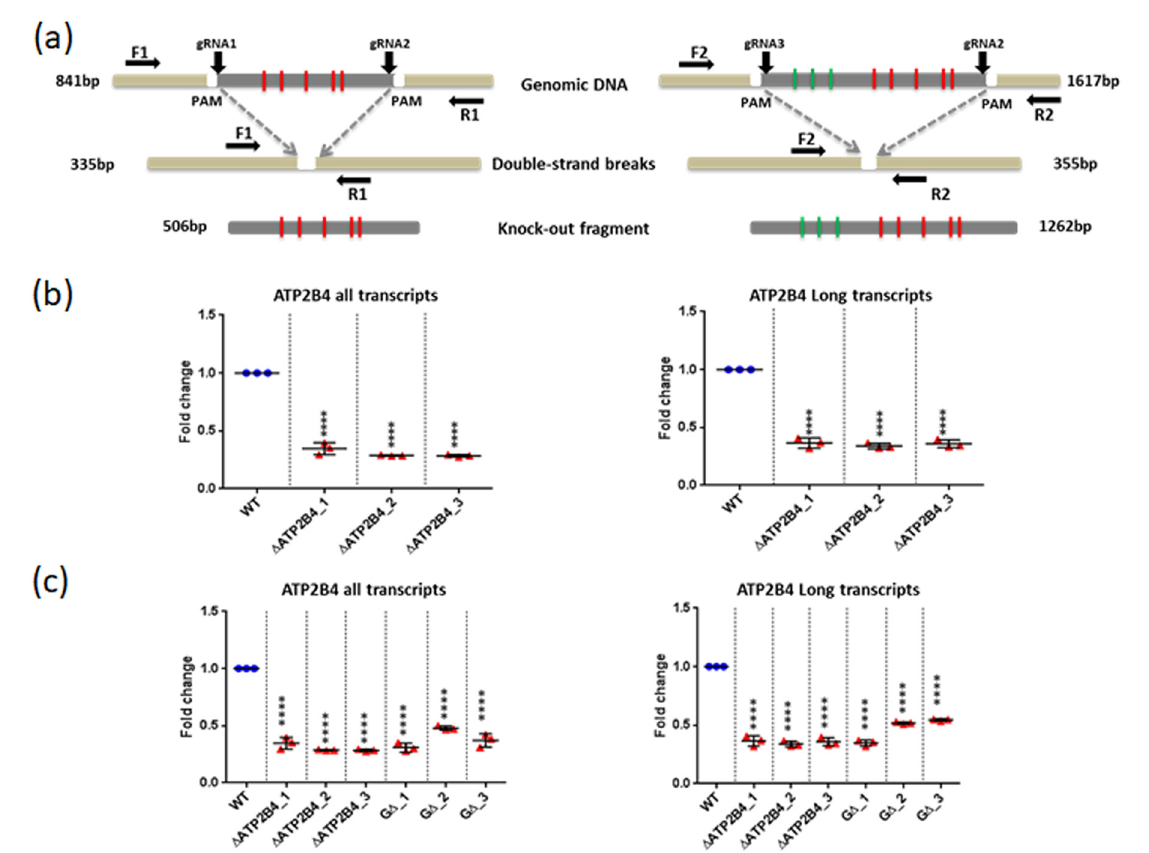
Figure 7. CRISPR-Cas9 mediated genome editing. ( a ) Principal strategy for the generation of DNA knockouts. gRNAs (gRNA1, gRNA2, and gRNA3) were designed flanking the genomic target to delete the two targeted DNA segments comprising either the five (506 bp) or the eight (1262 bp) candidate SNPs, creating double-strand breaks (DSBs) at 3 bp upstream of the PAM. The resulting DSB is repaired by the NHEJ pathway. The genomic deletion is detected by PCR using primers (F1, R1) and (F2, R2) providing the amplicons of 335 bp and 355 bp, respectively. ( b ) qPCR analysis of gene expression in wild-type K562 cells and the deleted ATP2B4 clones (for the five candidate SNPs) to quantify either all the transcripts or only the two long transcripts of ATP2B4 . ( c ) qPCR analysis of gene expression in wild-type K562 cells and the deleted ATP2B4 clones (for the eight SNPs) to quantify either all the transcripts or only the two long transcripts of ATP2B4 . Error bars illustrate standard deviation ( n = 3 independent RNA/cDNA preparations): **** p < 0.0001.